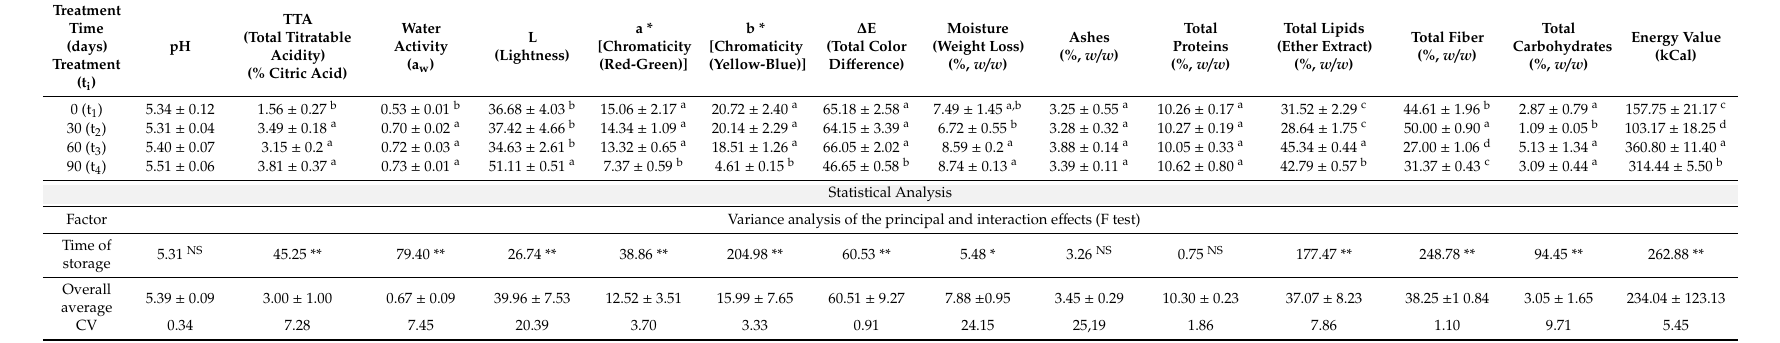
Table 3. Average values and standard deviations (mean ± STDV) from 3 analytical repetitions for di ff erent physicochemical parameters throughout 90 days of storage of cupuaçu beans : pH, Moisture (weight loss) (%, w / w ), Total Titratable Acidity (TTA) (mL NaOH 0.1 N / 10 g sample ), Water activity (a w ), the CIE 1976 L*a*b* color scale {L* (lightness), a*[chromaticity (red-green)], and b* [chromaticity (yellow-blue)]}, Total color di ff erence ( ∆ E), Total lipids (ether extract) (%, w / w ), Total fiber (%, w / w ), Total proteins (%, w / w ), Energy value (%, w / w ), Total proteins (%, w / w ), and Total carbohydrates (%, w / w ). Statistical analysis: F-tests Tukey post-hoc tests at 5% probability ( p ≤ 0.05) for the multiple comparison of mean di ff erences. Numbers from the same column with the same superscript letter are not significantly di ff erent, as obtained by the Tukey’s test ( p ≤ 0.05). NS = Not significant; * = Significant di ff erence ( p ≤ 0.05); ** = Significant di ff erence ( p ≤ 0.01); CV = Coe ffi cient of